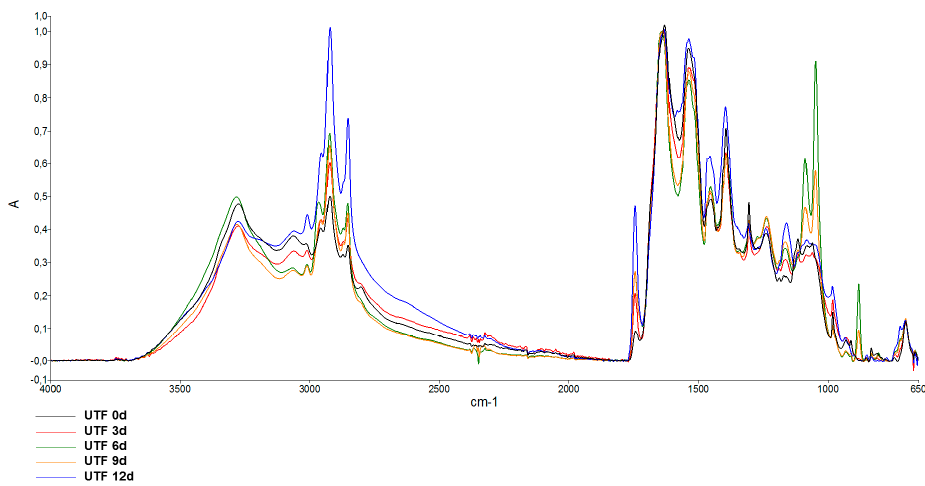
Figure 8. ATR-FTIR absorption spectra in the region 650–4000 cm − 1 of uncoated (UTF) trout fillets preserved at 4 ◦ C. Spectra were baseline corrected and normalized for Amide I. Spectra are representative of three samples.